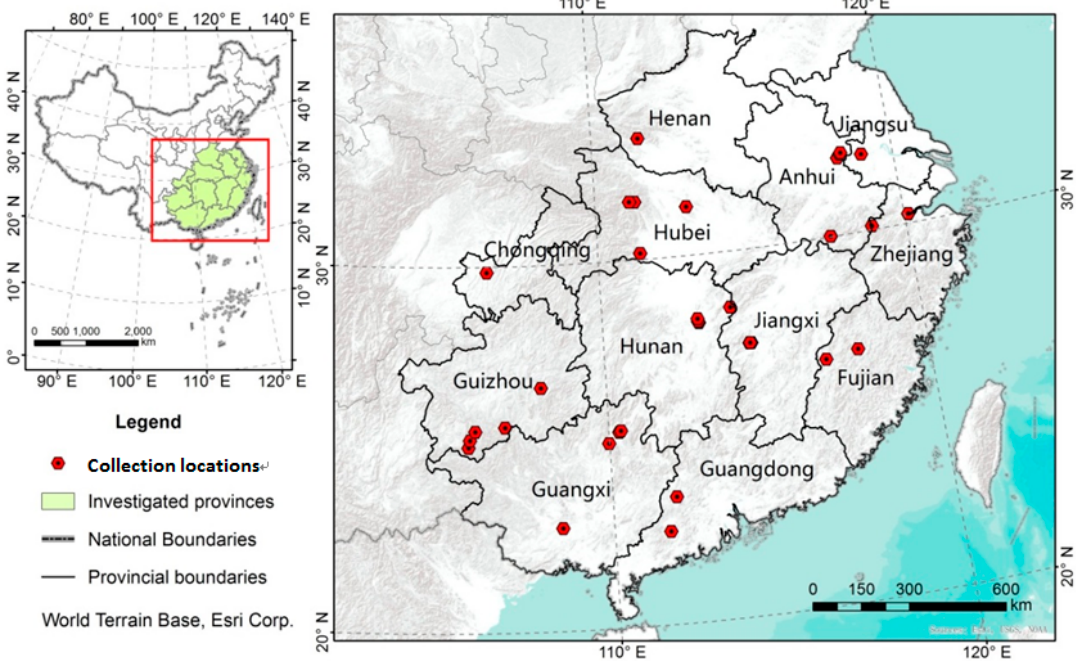
Figure 1. Sample collection locations of Sapindus mukorossi fruits, southeastern China.